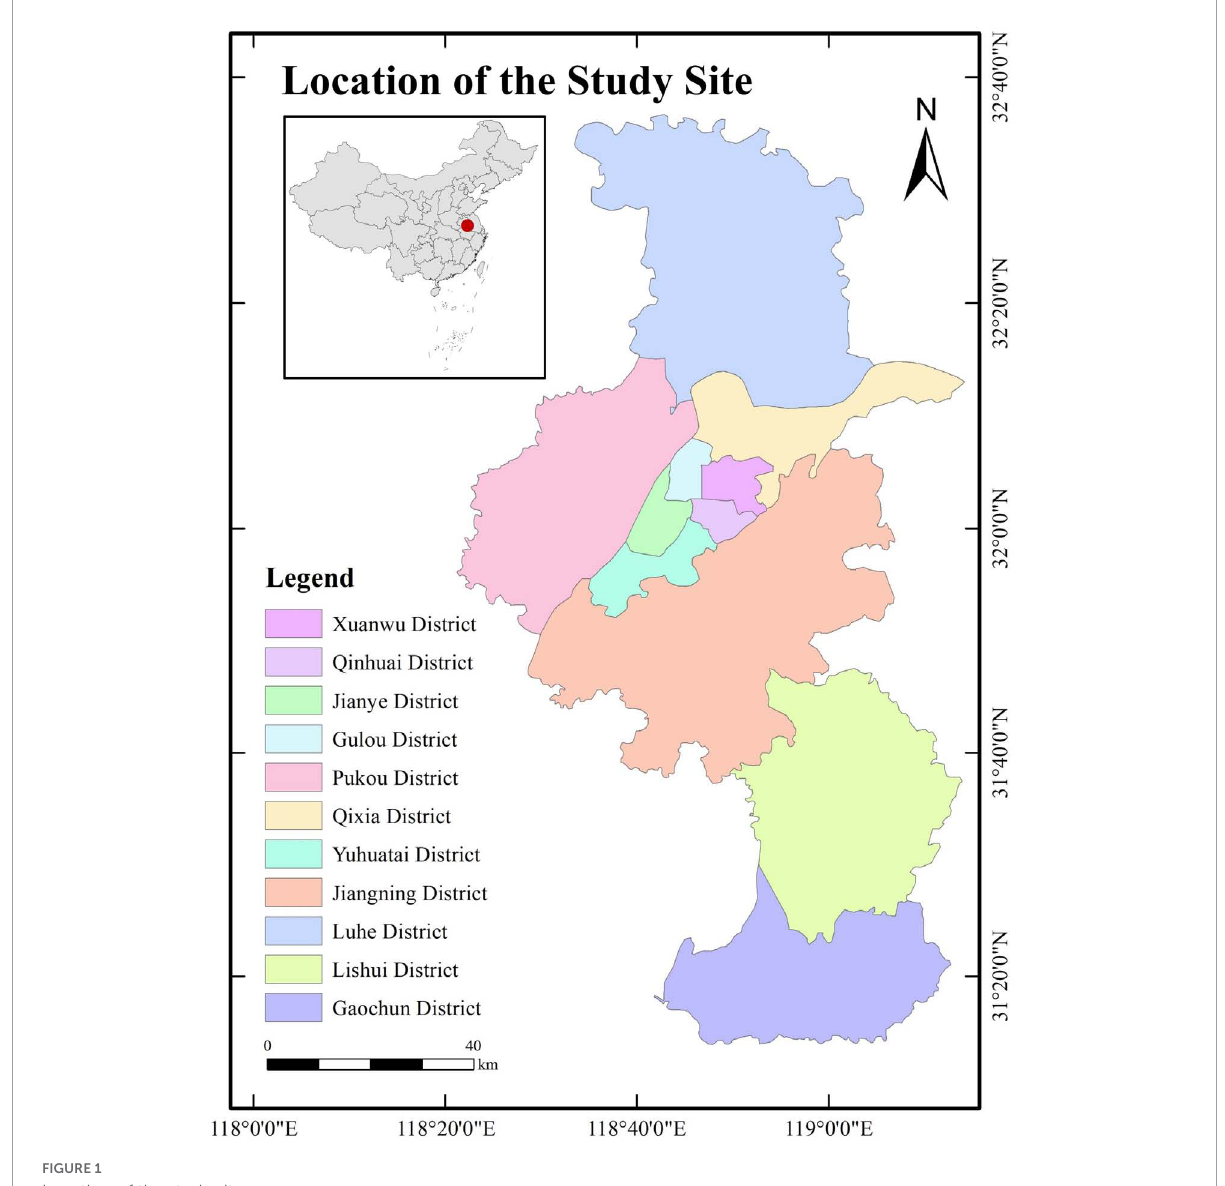
FIGURE1 Location of the study